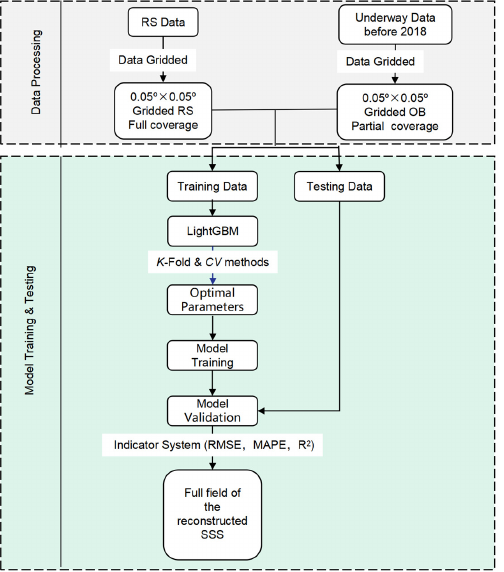
Figure 2. Procedure for the reconstruction of sea surface salinity (SSS) using machine learning; RS represent remote sensing data and OB observational data; CV indicates cross validation, RMSE represents the root mean square error, MAPE represents the mean absolute percentage error, and R 2 represents the coefficient of determination.